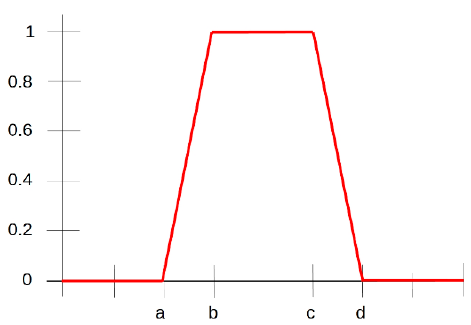
Figure A1. Trapezoidal membership function.